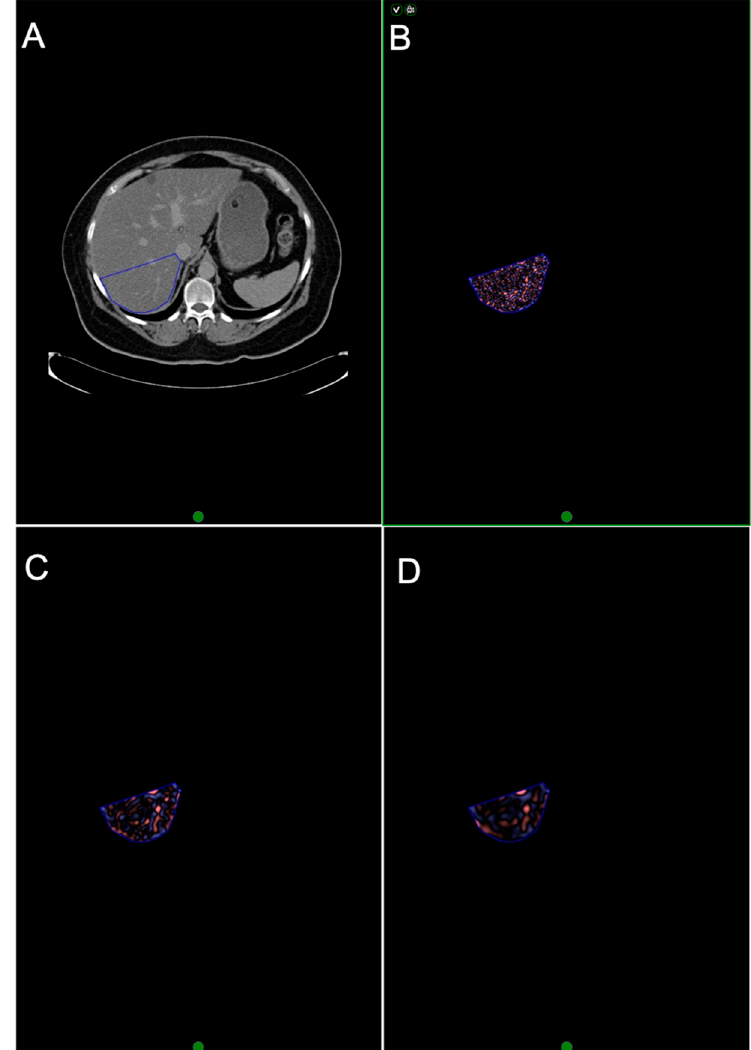
Figure 4. Texture analysis of EQ-CT data in liver segment VII. ( A ) EQ-CT (post-contrast phase) showing liver segment VII region of interest. ( B – D ) highlights the initial filtration step, where B reflects fine (features of 2 mm in size) texture map, C reflects medium (4 mm) texture map and D reflects coarse (6 mm) texture map. (EQ-CT: equilibrium contrast-enhanced CT.)